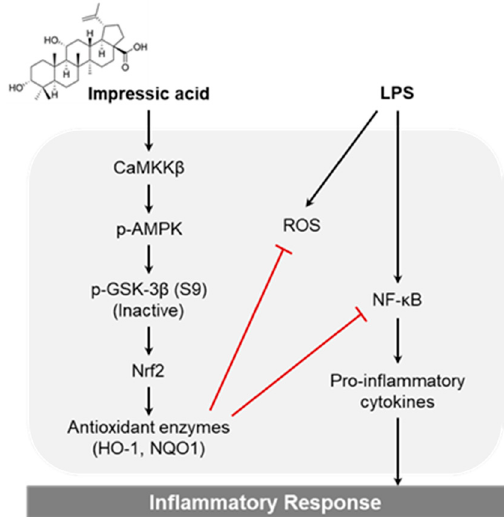
Figure 6. Proposed mechanism of the anti-inflammatory effect of IPA via the AMPK/GSK3 β /Nrf2 signaling pathway in RAW264.7 macrophages. IPA increased the activity of CaMKK β by increasing the intracellular calcium levels and activating the phosphorylation of AMPK and GSK3 β , leading to increased protein levels of Nrf2, HO-1, and NQO1. Consequently, IPA attenuated LPS-induced inflammation by promoting the production of antioxidant enzymes via the AMPK/GSK3 β /Nrf2 signaling axis.